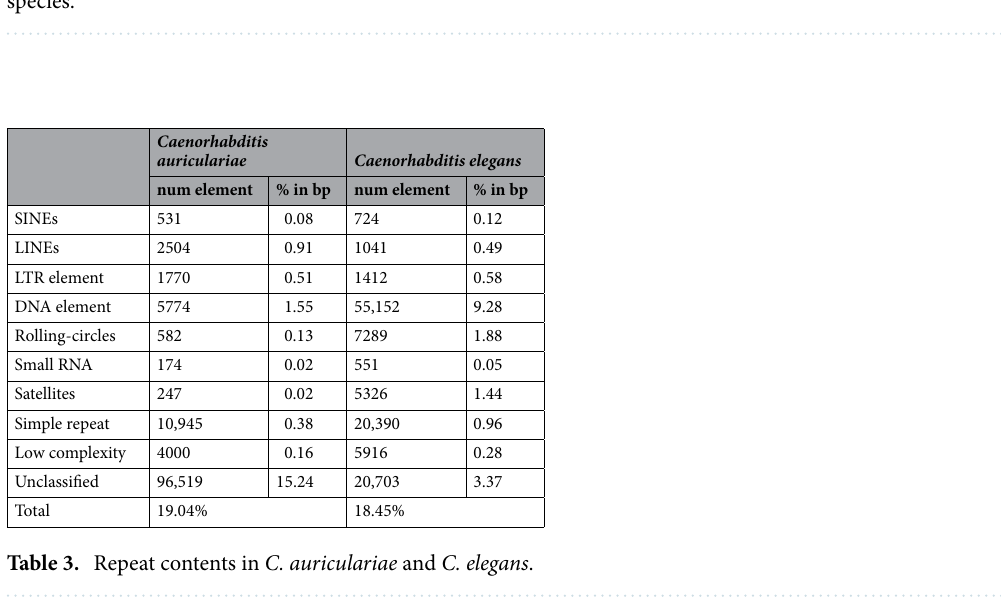
CEGMA com- plete/partial % 95.97/99.60 Table 2. Genome and gene model statistics for C. auriculariae and comparisons of other Caenorhabditis species.